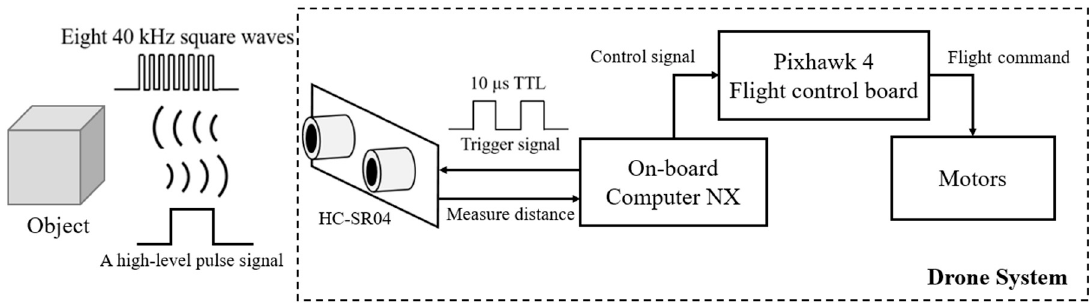
Figure 24. Illustration of the ultrasonic